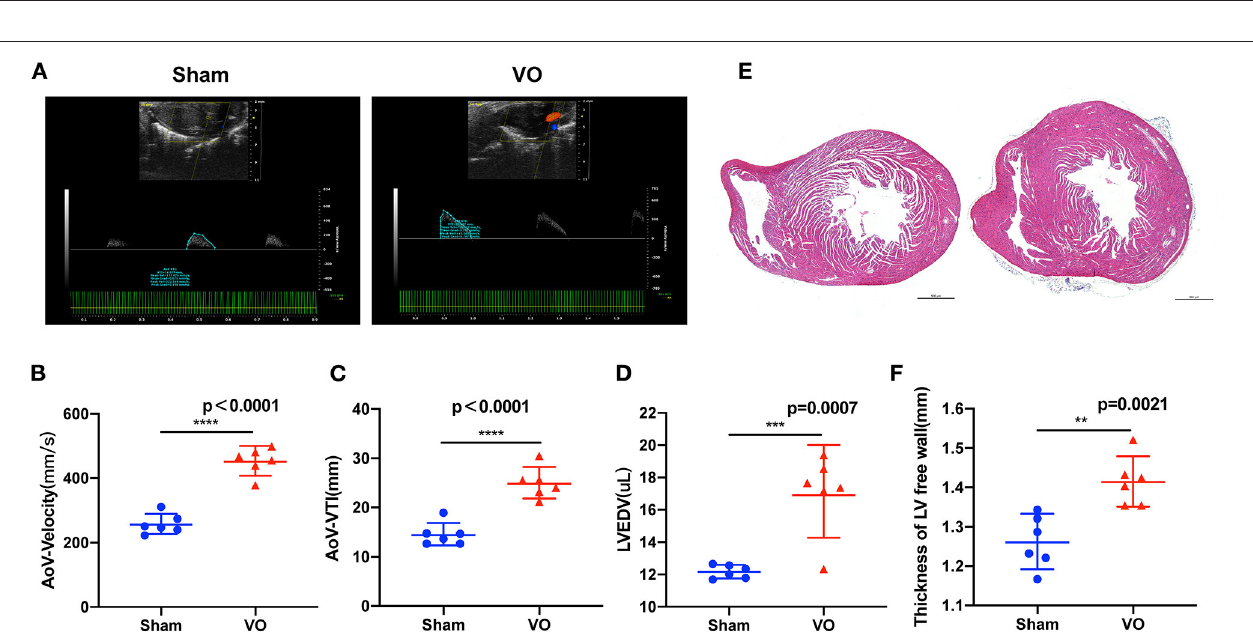
FIGURE 2 | Left ventricular (LV) volume overload (VO) increased in the ACF model. (A) The representative echo image showed that, 2 weeks after the creation of fistula, the aortic valve (AoV) velocity and the velocity–time integral (VTI) in the VO group were increased. (B) Quantification of AoV–velocity in the Sham and VO groups, n = 6, Student’s t -test. (C) Quantification of AoV–VTI in the Sham and VO groups, n = 6, Student’s t -test. (D) Quantification of LV end-diastolic volume (LVEDV) in the Sham and VO groups, n = 6, Student’s t -test. (E) Hematoxylin and eosin staining showed that, two-weeks after the creation of the fistula, the free wall of the LV was thickened in the VO group. (F) Quantification of the thickness of the free wall of the LV, n = 6, Student’s t -test. ** p < 0.01, *** p < 0.001, **** p < 0.0001.